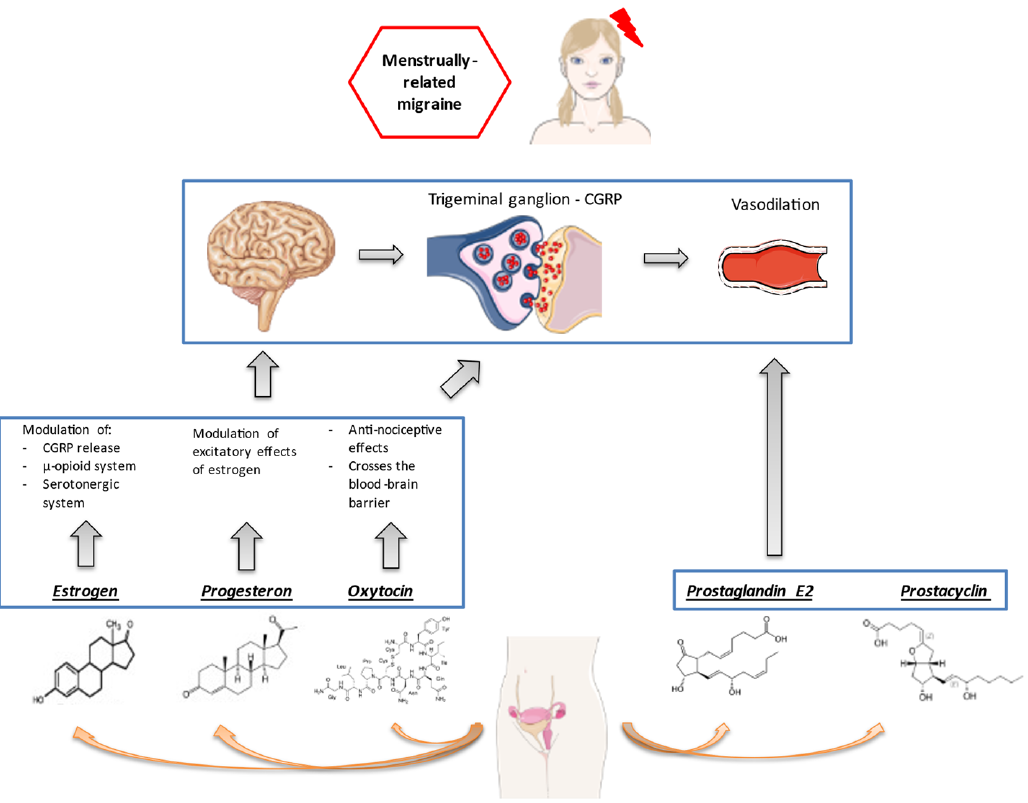
Figure 1. Female sex hormones and pathogenesis of menstrual migraine.